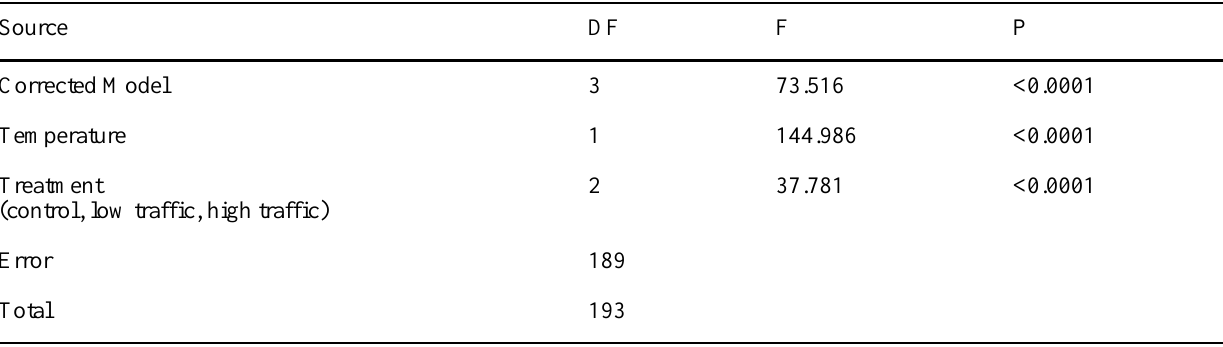
Table 1. Type I ANOVA of the effects of treatment and temperature on the time taken by frogs (seconds) to cross 10 m. Adjusted R 2 for the model =